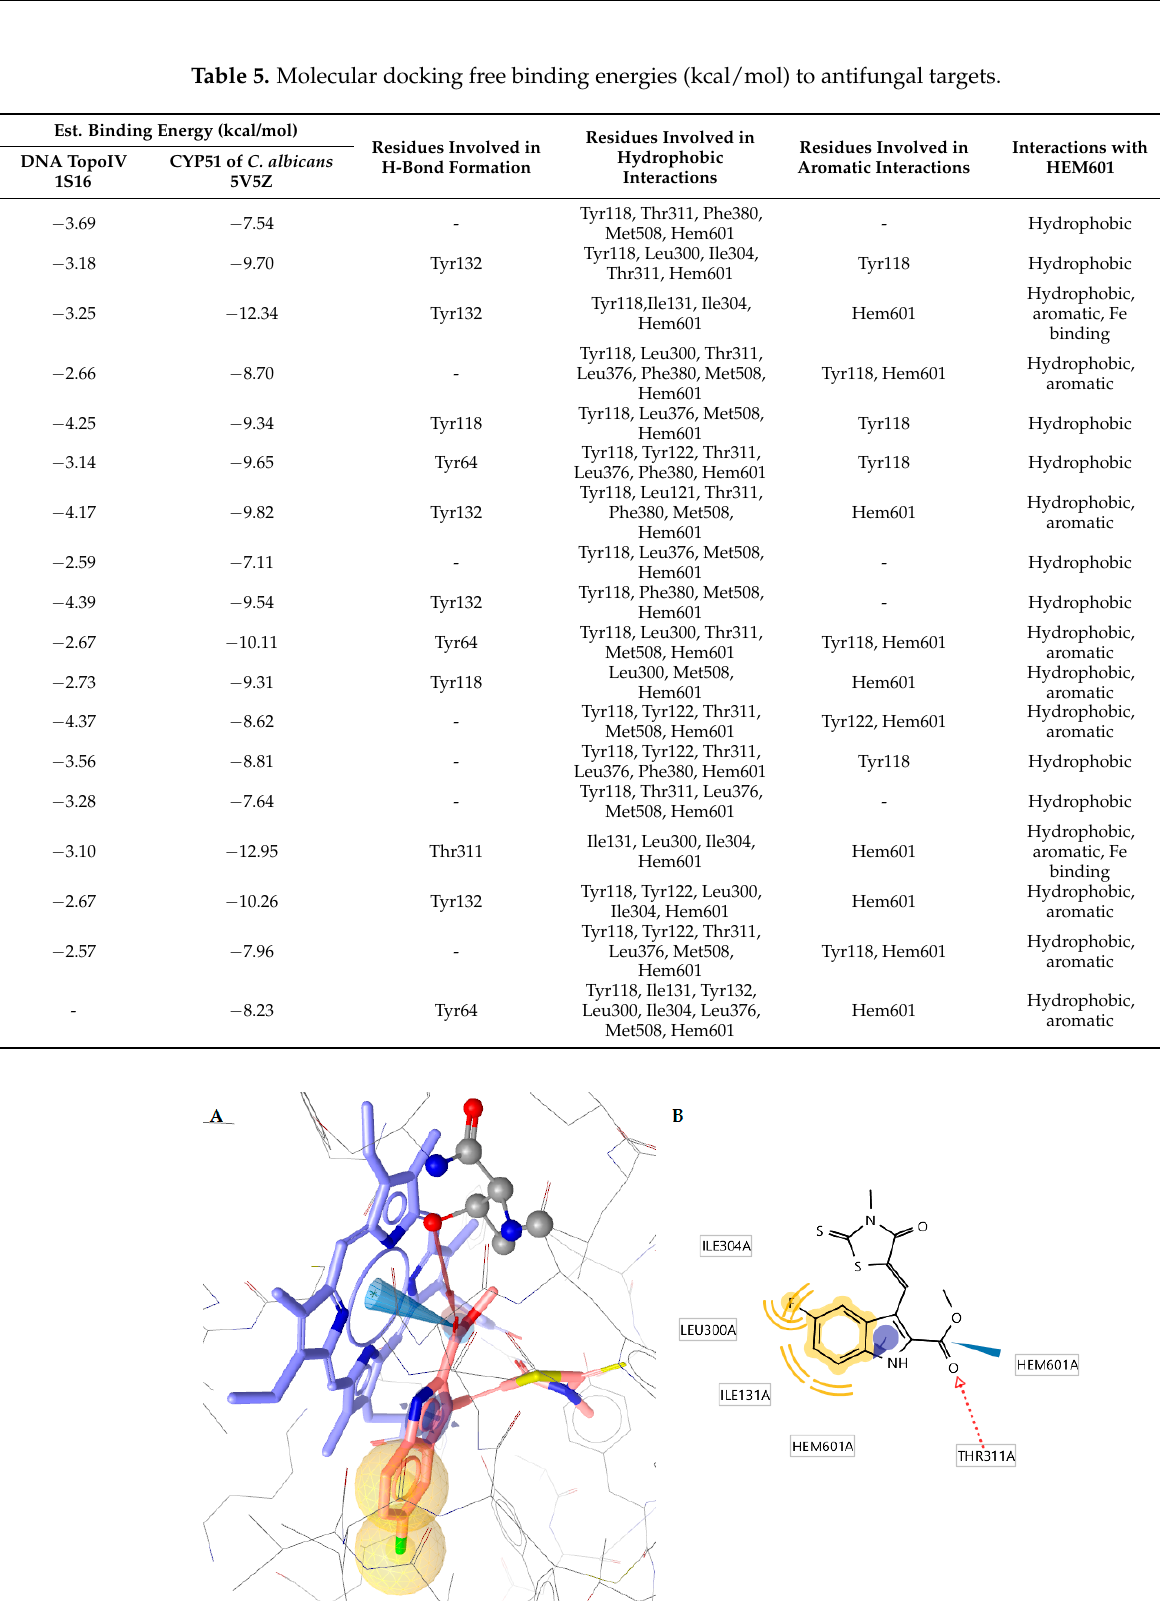
Figure 6. Docked conformation of ketoconazole in lanosterol 14 α -demethylase of C . albicans (CYP51 ca ). 2.5. Drug-Likeness and Bioavailability The drug-likeness and bioavailability scores of all tested compounds are shown in Table 6. According to prediction, the bioavailability score of most of the compounds was about 0.55, except for compounds 2 , 9 , 12 , 14 , and 17 with a value of 0.11. According to the BOILED-Egg illustration (Figure 7A), all compounds are predicted to demonstrate moderate to high gastrointestinal (GI) absorption. Especially, compounds 5 , 6 , 7 , 15 , and 16 are predicted to be passively absorbed by the gastrointestinal tract. In addition, none of the examined compounds are predicted to passively permeate the blood–brain barrier. All compounds showed no violation of Lipinski’s rule of five. Half of the compounds demonstrated a TPSA value < 140 Å, thus indicating their good oral bioavailability. Furthermore, all compounds displayed moderate drug-likeness scores ranging from − 0.95 to 0.38, probably due to the enhanced TPSA values and the absence of a basic moiety on rhodanine’s nitrogen. The best in silico prediction was achieved for compound 5 , bearing the basic propyl-morpholine group with a drug-likeness score of 0.24 (Figure 7, Table 6).